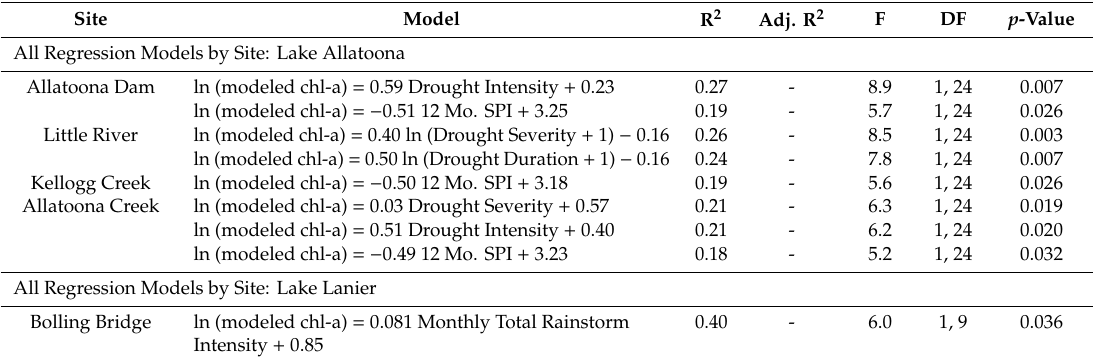
Table A4. Regression Models by Lake and Site with Data Modeled by Remote Sensing.